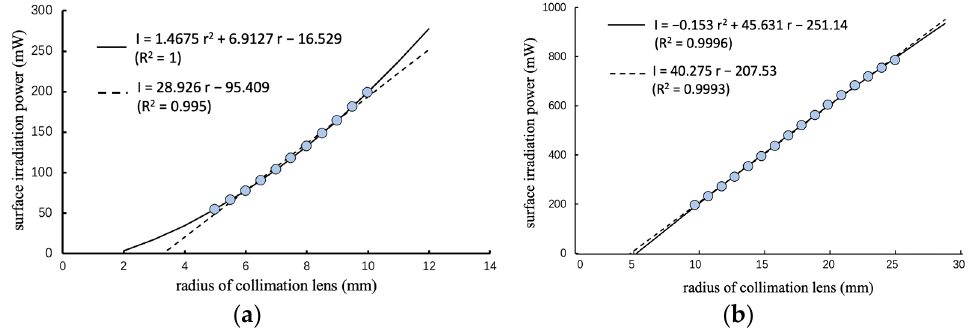
Figure 3. Optimal irradiation power regression: ( a ) 0 < r ≤ 10 mm; ( b ) 10 < r ≤ 25